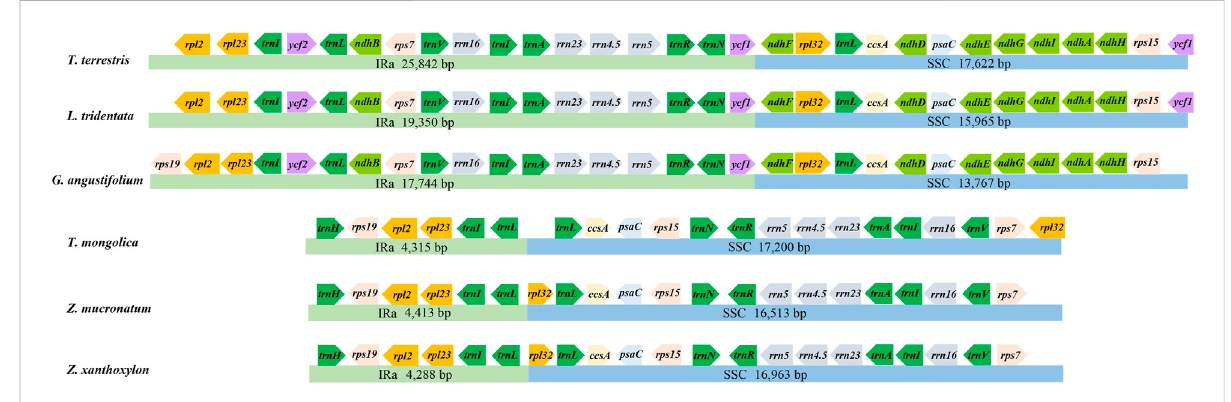
FIGURE 2 Genes in IRa and SSC of Zygophyllaceae chloroplast genomes.